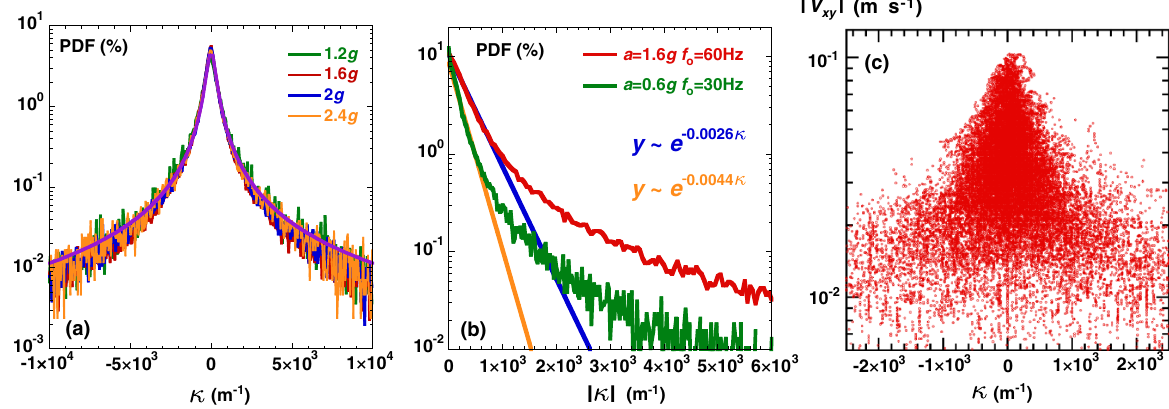
ð t Þ measured at f ¼ 60 Hz for different vertical accelerations a ¼ 1 . 2 , 1.6, 2, 2 . 4 g ( a ¼ 0 . 6 g ), FIG. 5. (a) PDFs of the curvature κ 0 T f th the purple solid line corresponds to a fit by a q -Gaussian distribution P ð κ Þ ¼ α ½ 1 − β ð 1 − q Þ · κ 2 (cid:1) 1 = 1 − q . (b) PDFs of the absolute value ð t Þj for different excitation frequencies f ¼ 30 , 60 Hz and similar supercriticality. The PDF at low curvature of the curvature j κ 0 T f j κ j < 1000 m − 1 is fitted by an exponential law P ð κ Þ ¼ α exp ð − l κ Þ , where l is a characteristic decay length scale. The Faraday T f c c j versus curvature κ ð t Þ wavelength is λ ≈ 14 , 8 mm for f 0 ¼ 30 , 60 Hz, respectively. (c) Absolute value of the horizontal velocity j v xy T f along trajectories recorded in FW at f 0 ¼ 60 Hz ( a ¼ 1 . 6 g , ϵ ¼ 1 . 67 ). Data plotted in (a) – (c) were obtained from trajectories recorded in a 8 × 8 cm 2 domain imaged at 120 Hz with a spatial resolution of 100 μ